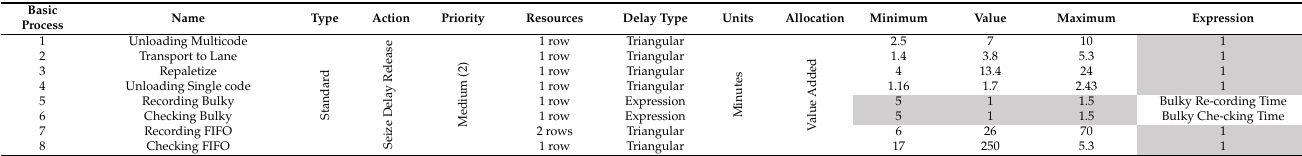
Table 5. Processes details.